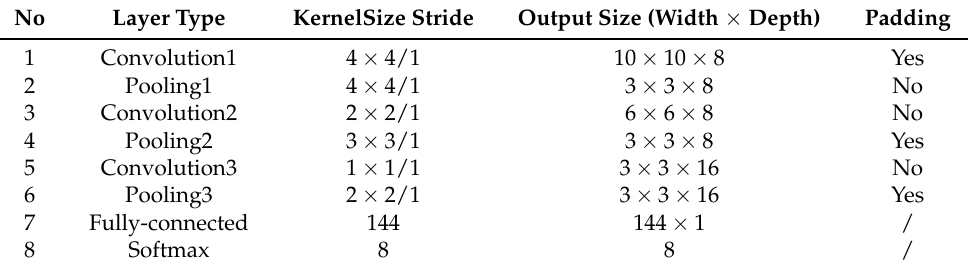
Table 3. Structural parameters of convolutional neural